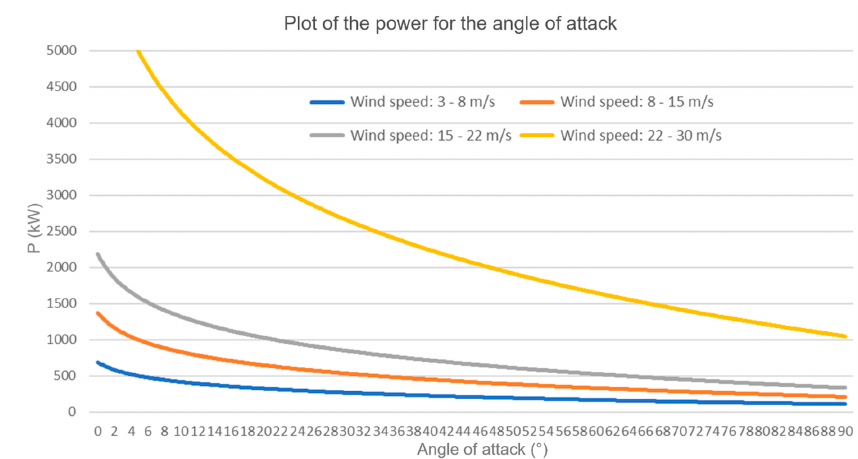
Figure 9. Graphical dependence of turbine power on the angle of attack [source: author’s archive] .